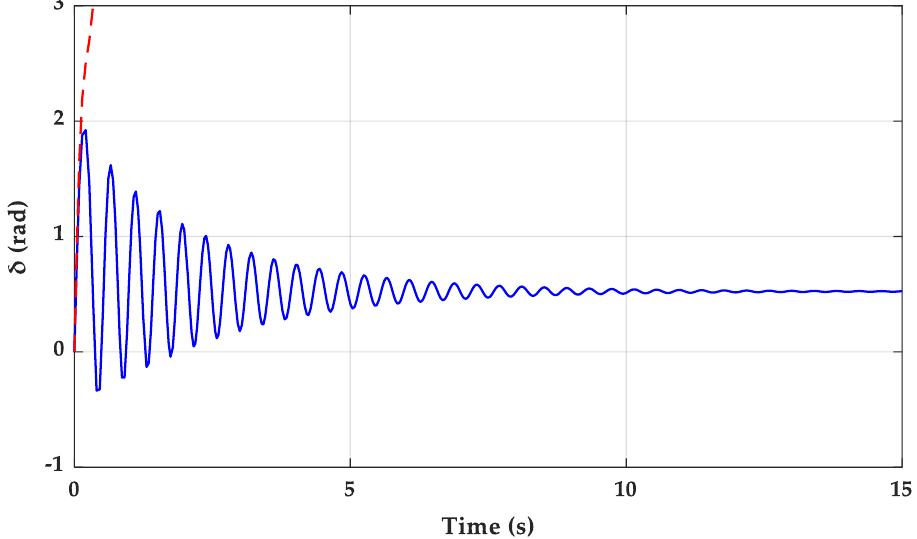
Figure 3. Angle response of the SGIB power system. Energies 2020 , 13 , x FOR PEER REVIEW